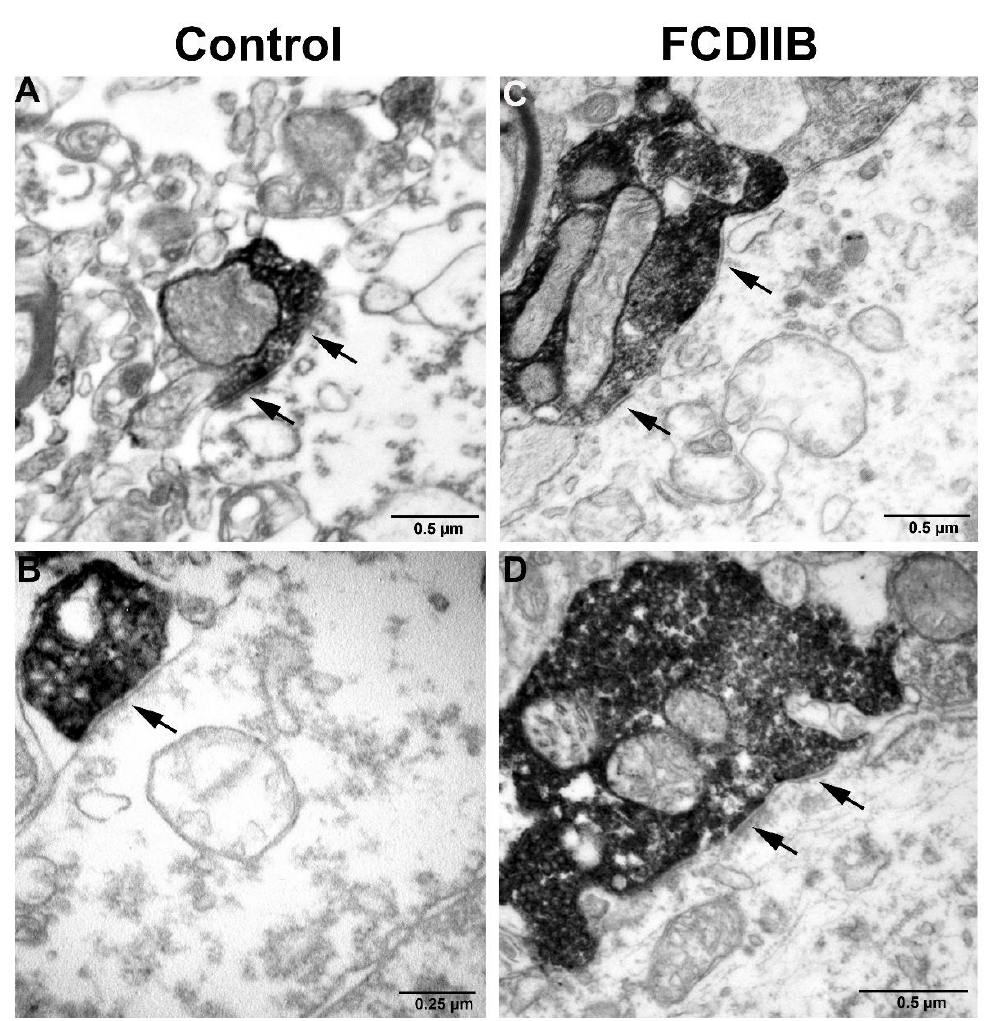
Figure 5. Parvalbumin (PV) immunostained sections of the somata of principal cells in prefrontal cortex of control ( A , B ) and FCDIIB (with abnormal cell types, C , D ) subjects in layer III by electron microscopy. The PV-immunopositive perisomatic terminals are establishing symmetrical synapses with the principal neurons (arrows). Scales: ( A , C , D ): 0.5 µm, ( B ): 0.25 µm.